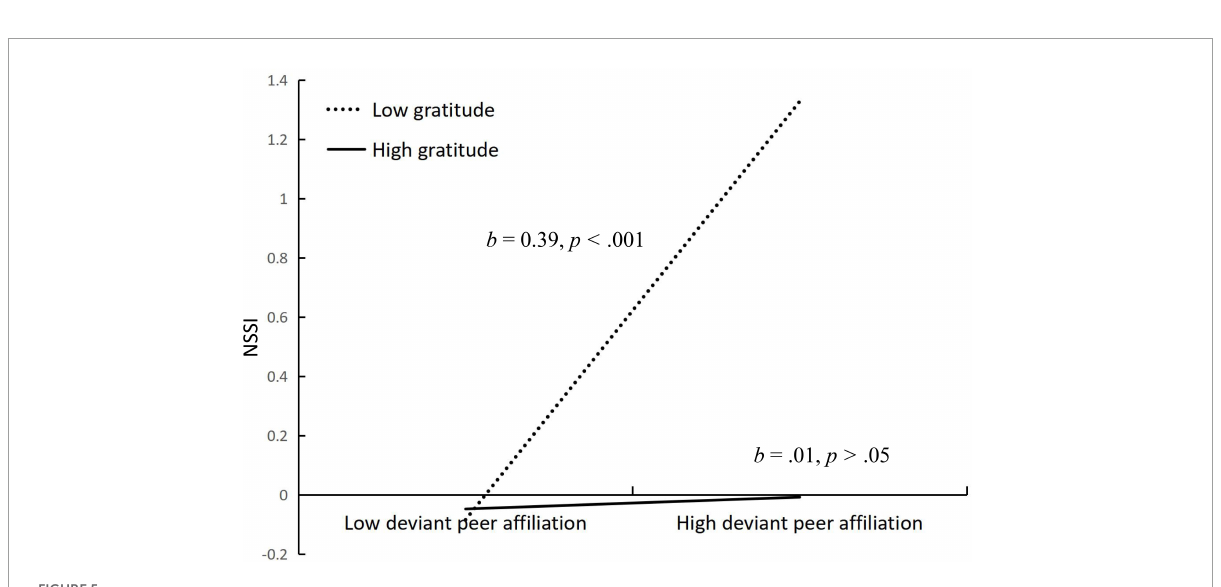
FIGURE5 Interactive effect of deviant peer affiliation and gratitude on NSSI. NSSI, non-suicidal self-injury. Gratitude is graphed for two groups of participants: high gratitude (1 SD above the mean) and low gratitude (1 SD below the